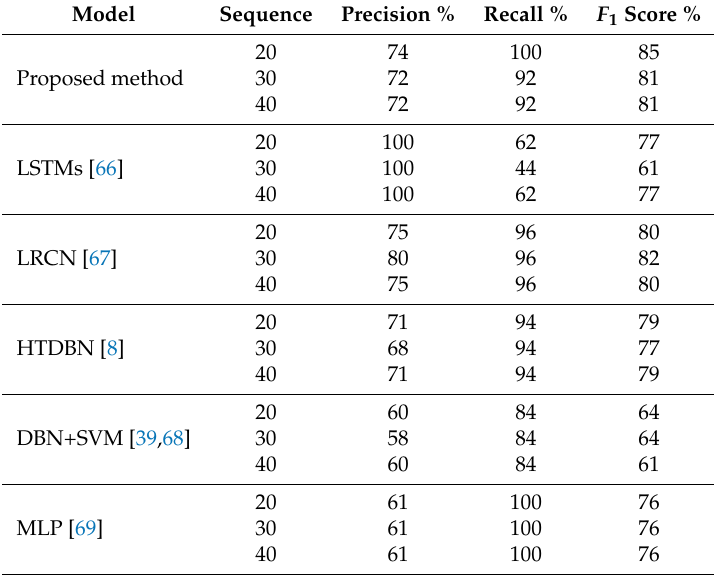
Table 2. F 1 Score experimental